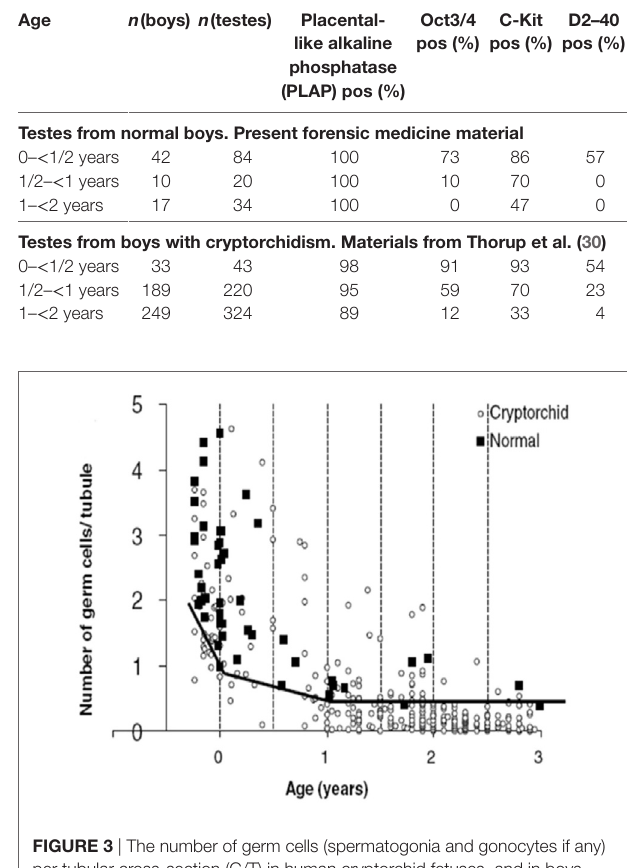
FigUre 3 | The number of germ cells (spermatogonia and gonocytes if any) per tubular cross-section (G/T) in human cryptorchid fetuses, and in boys who underwent surgery for cryptorchidism < 3 years of age. Furthermore, G/T in normal human fetuses and normal boys who died < 3 years of age. The solid line indicates the lowest normal G/T. Data with permission from Cortes (31) and Cortes et al. 1995